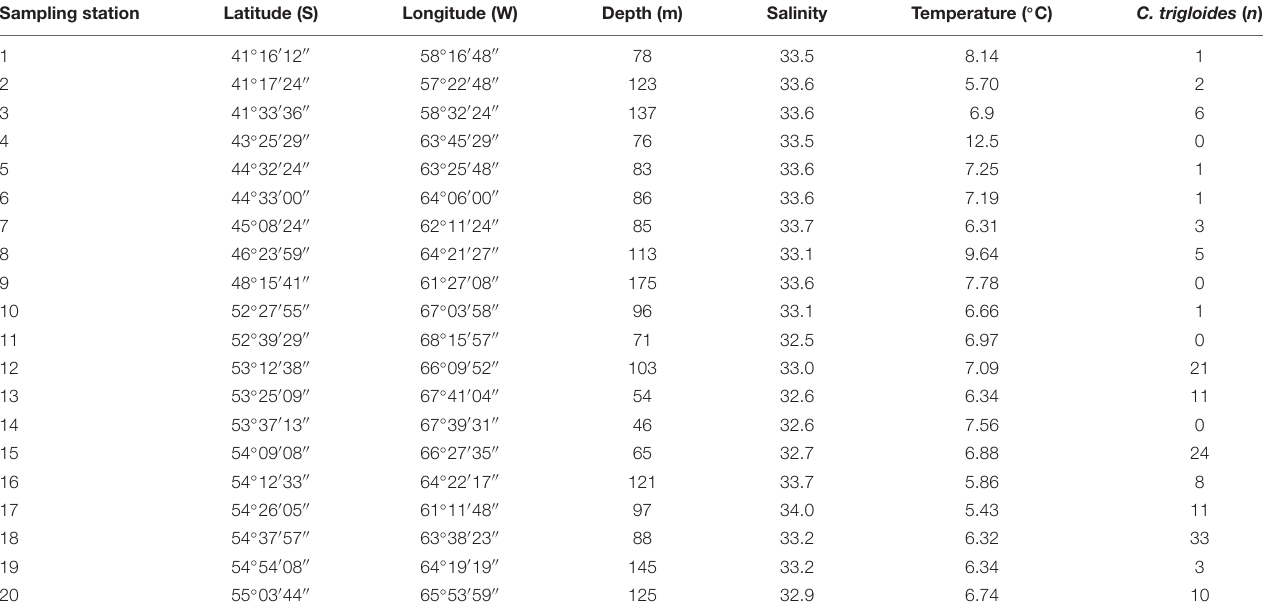
TABLE 1 | Location of sampling stations, environmental factors measured, and the number of C. trigloides captured in the southwestern Atlantic Ocean. Sampling station Latitude (S) Longitude (W) Depth (m) Salinity Temperature ( ◦ C)